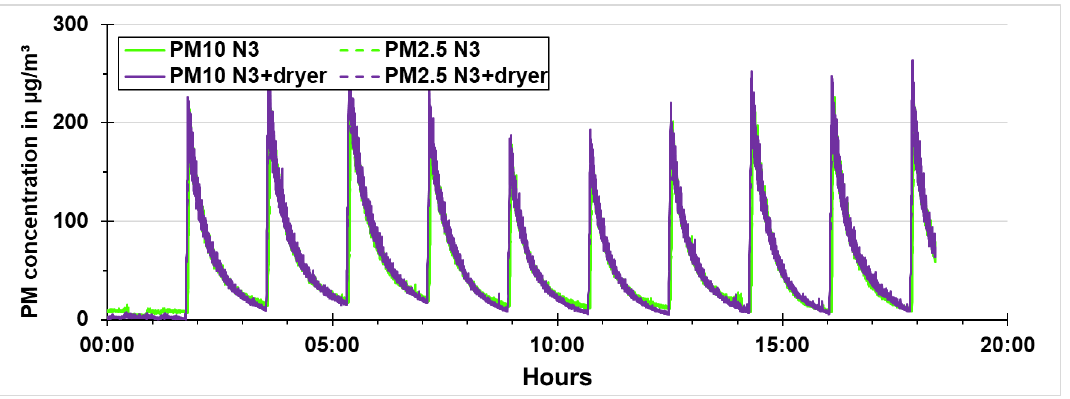
Figure 17. PM concentrations of the low-cost PM sensors during quality assurance.